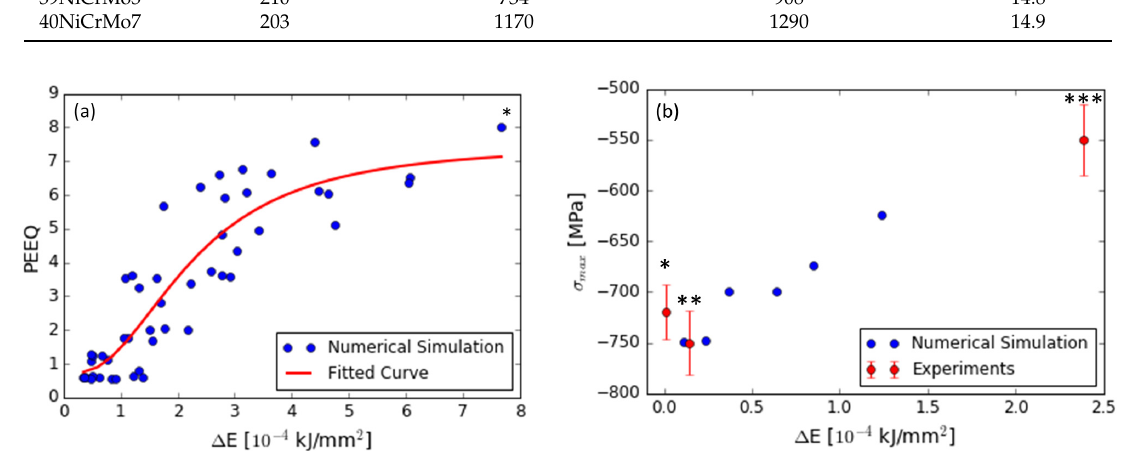
Figure 5. ( a ) The surface variation of equivalent plastic strain (PEEQ) in the multiple impact model as a function of the kinetic energy per unit area (the topmost data point on the left represents severe shot peening cases); ( b ) the max in-depth residual stress obtained by FEM compared with comparted experimental data (* corresponds to experimental data for 40NiCrMo7 (shot size 0.3 mm, Almen intensity 4–6 A (0.0001 in.) and 100% coverage); ** corresponds to experimental data for 40NiCrMo7 (shot size 0.43 mm, Almen intensity 10–12 A (0.0001 in.) and 100% coverage); *** corresponds to experimental data for 39NiCrMo3 (shot size 0.6 mm, Almen intensity 7C (0.0001 in.) and 1500% coverage)).